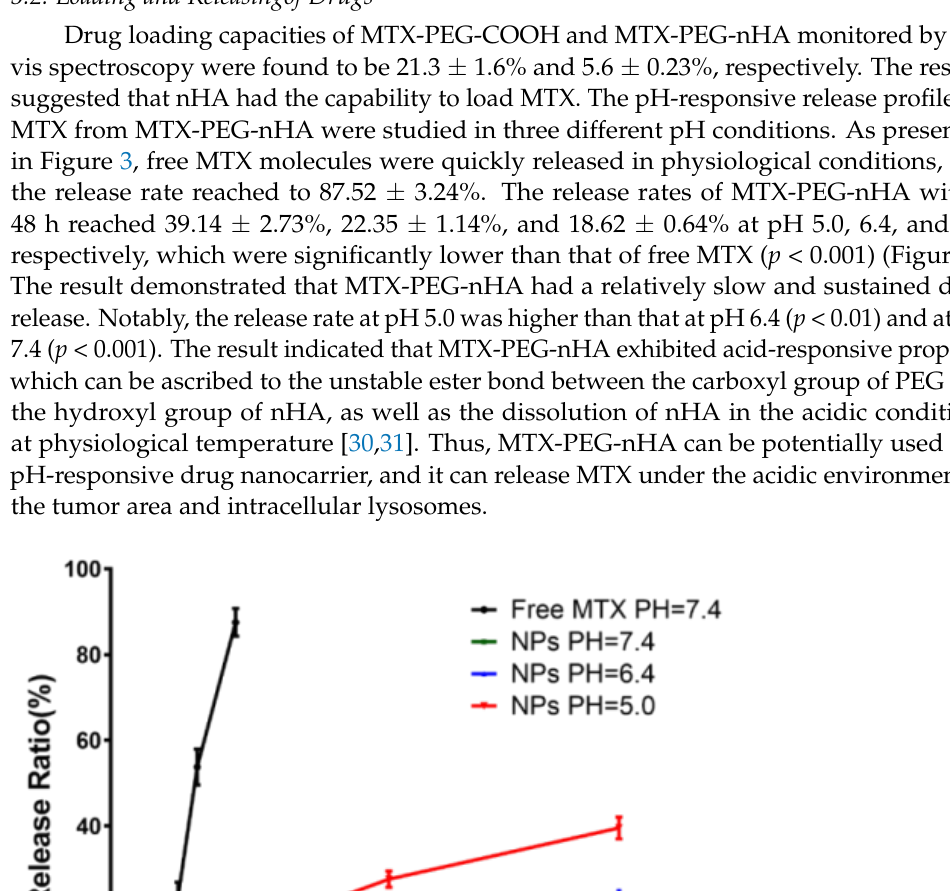
Figure 3. Release curves of free MTX in PBS (pH 7.4) and MTX-PEG-nHA in PBS with three dif- ferent pH values (5.0, 6.4, 7.4). The data were obtained from three separated experiments, and the bars represent standard errors ( n = 3).